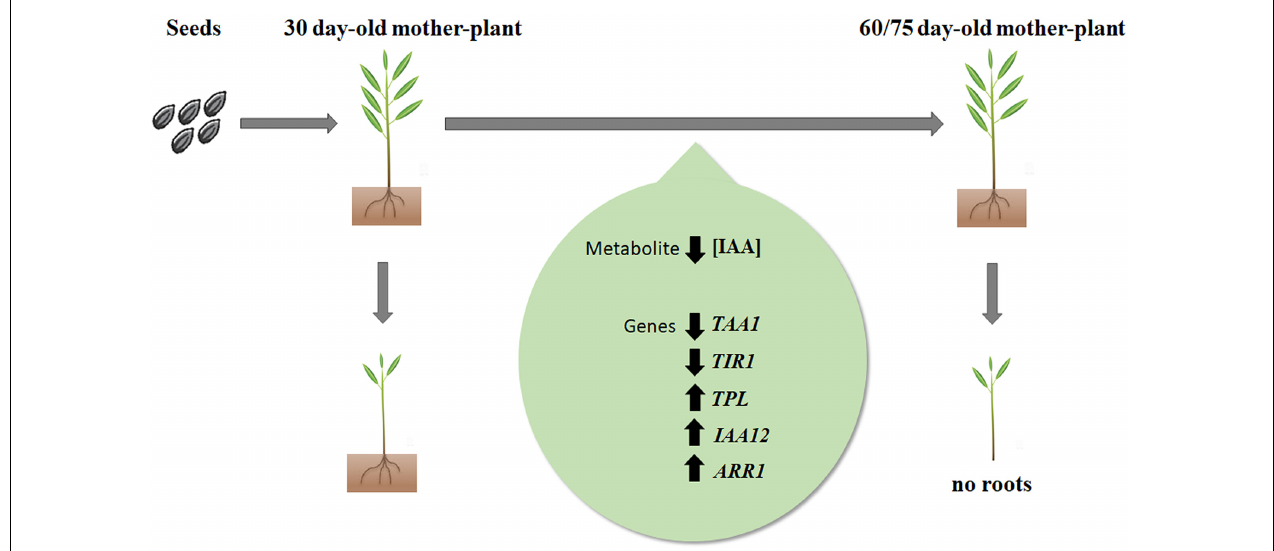
FIGURE 5 | Working model of biochemical and molecular changes associated with loss of adventitious rooting capacity in E. globulus Labill. microcuttings as a function of mother-plant age. Decrease in concentration of endogenous IAA as well TAA1 and TIR1 expression, associated with increase in expression of TPL, IAA12 and ARR1 , lead to loss of rooting capacity. Upward arrows represent increased gene expression; downward arrows represent decreased gene expression or IAA